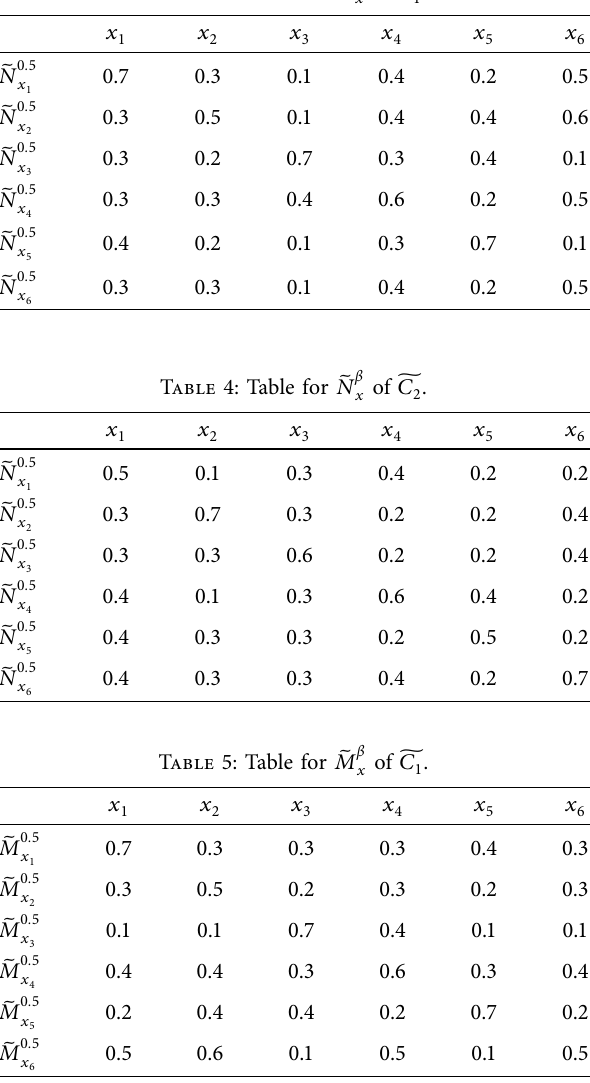
Table 3: Table for 􏽥 N β